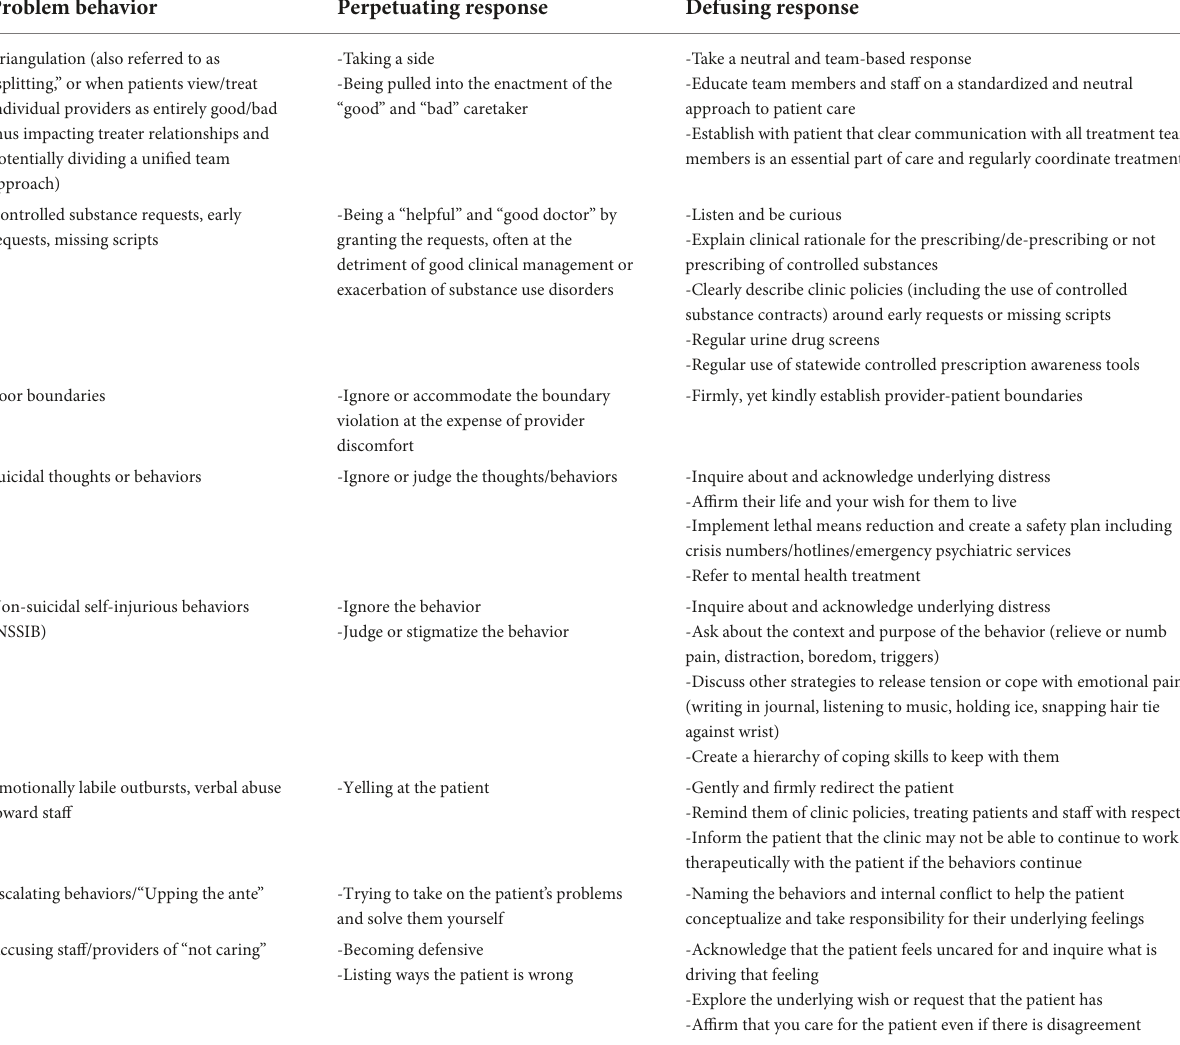
TABLE 1 Challenging behaviors and example